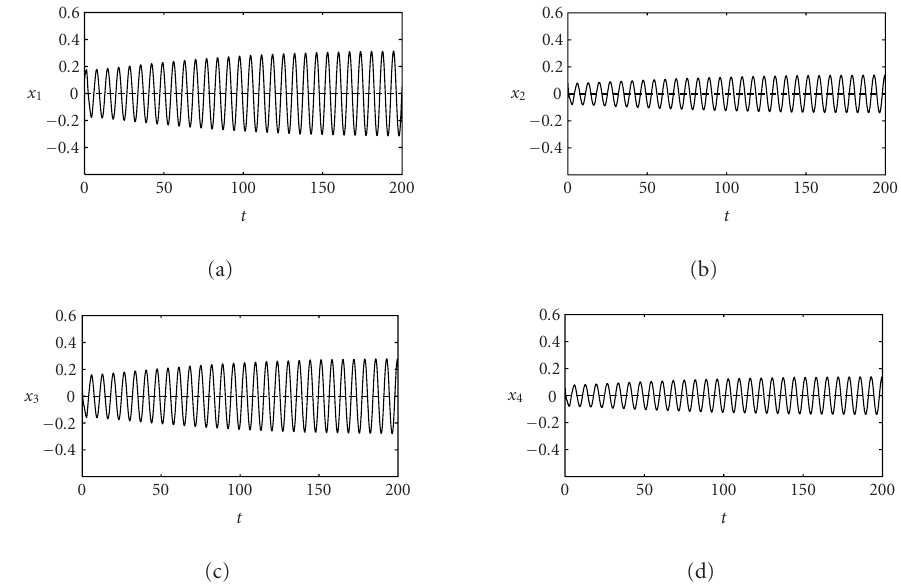
Figure 5.4. The trajectories graphs of system (5.14) with τ 1 = 1 . 2, τ 2 = 1 . 3, and initial data x 1 ( t ) = x 2 ( t ) = x 3 ( t ) = x 4 ( t ) = 0 . 09, t ∈ [ − 1 .